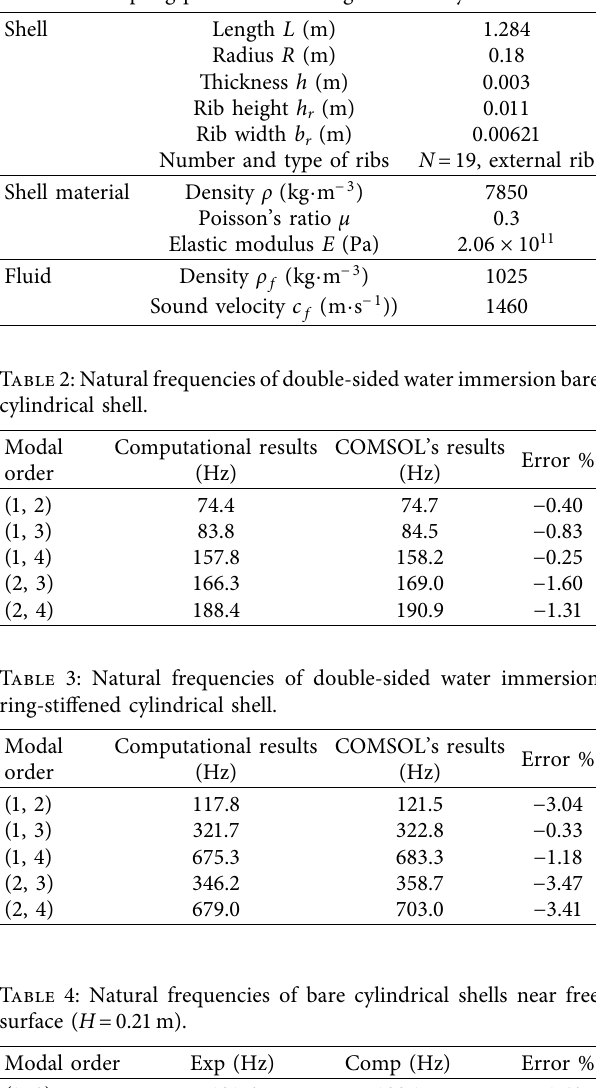
Table 1: Coupling parameters of ring-stiffened cylindrical shell.